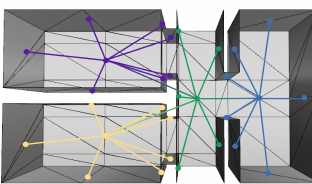
Figure 8. G (cid:48) in its spectral (left) and positional embedding (right).